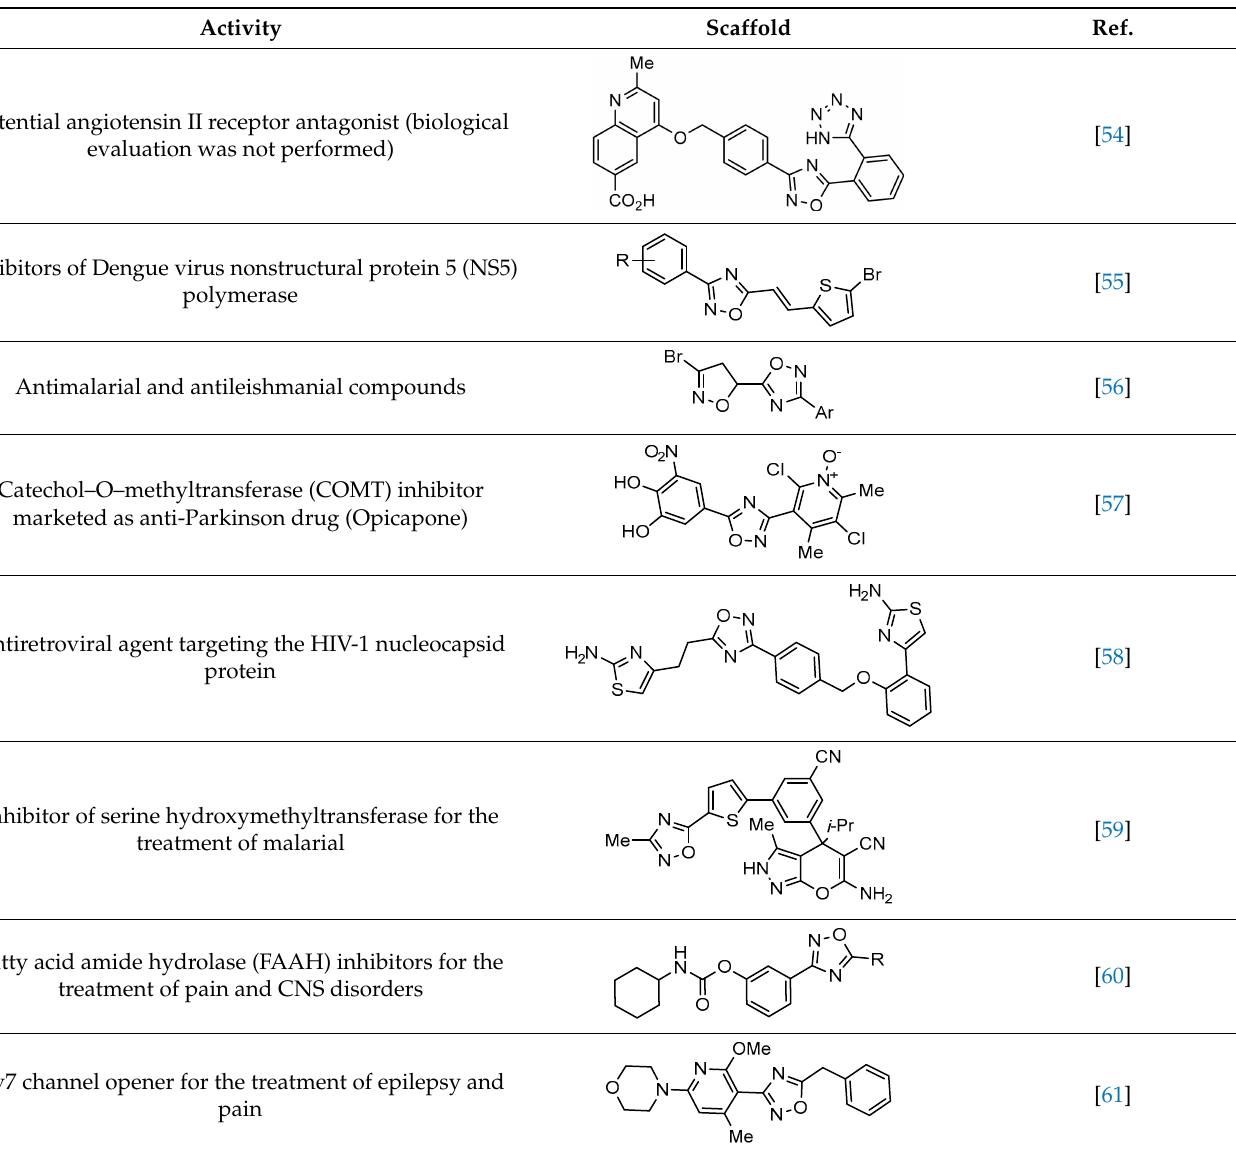
Table 1. Bioactive 1,2,4-oxadiazoles synthesized using TBAF.